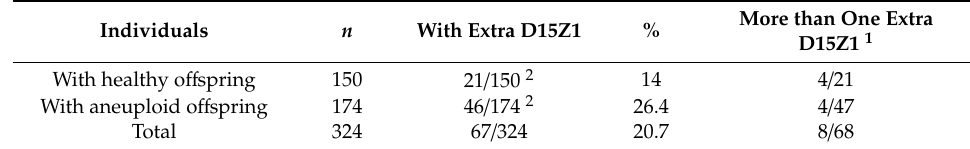
Table 3. Distribution of D15Z1 polymorphism in individuals from couples with healthy or aneuploid o ff spring.